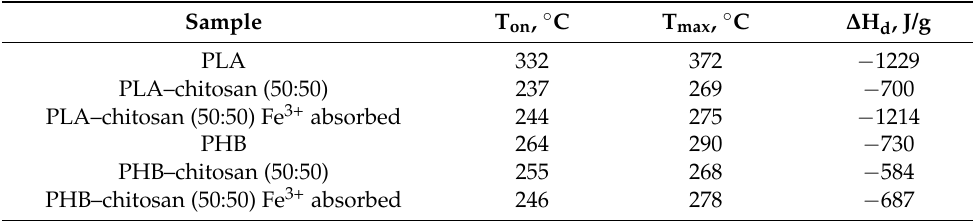
Figure 4. DSC heat flow curves of PHB (1), PHB–chitosan (50:50) wt. % composition (2) and PHB– chitosan (50:50) wt. % composition containing sorbed Fe 3+ ions (3), obtained by heating up to 400 ◦ C. Table 3. Thermal stability characteristics of PLA and PHB and their compositions with chitosan (Supplementary Materials: Calculation of the thermophysical parameters obtained by